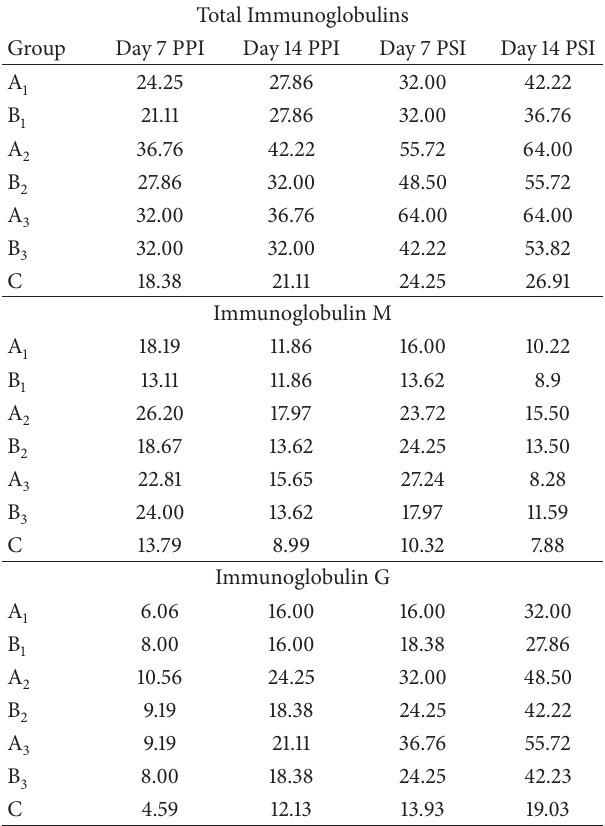
Table 2: Antibody titers (geomean titres) to sheep red blood cells in experimental and control groups.